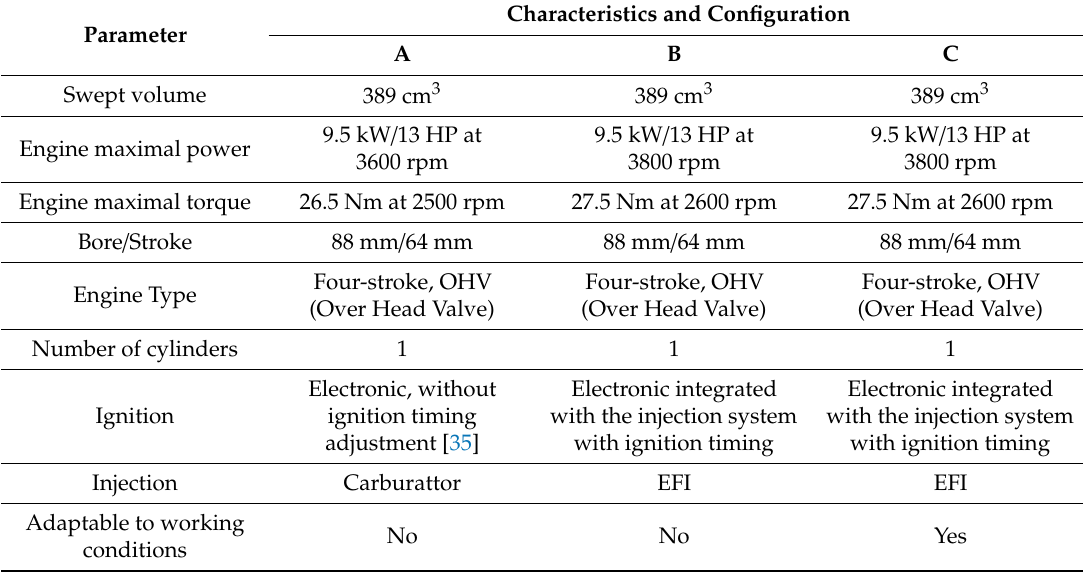
Figure 2. Schematic of the innovative injection-ignition system used in the German GX390 with a maintenance-free detection and adaptive chipper drive control system. Table 1. Technical specification of German GX390 engine in configuration: A: carburettor fuel supply